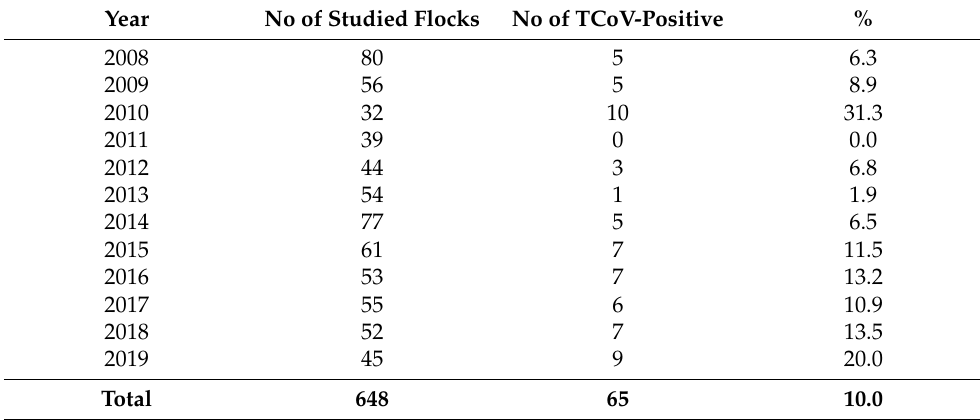
Table 1. Prevalence of TCoV infections detected in samples from all 648 commercial turkey flocks collected between 2008–2019.